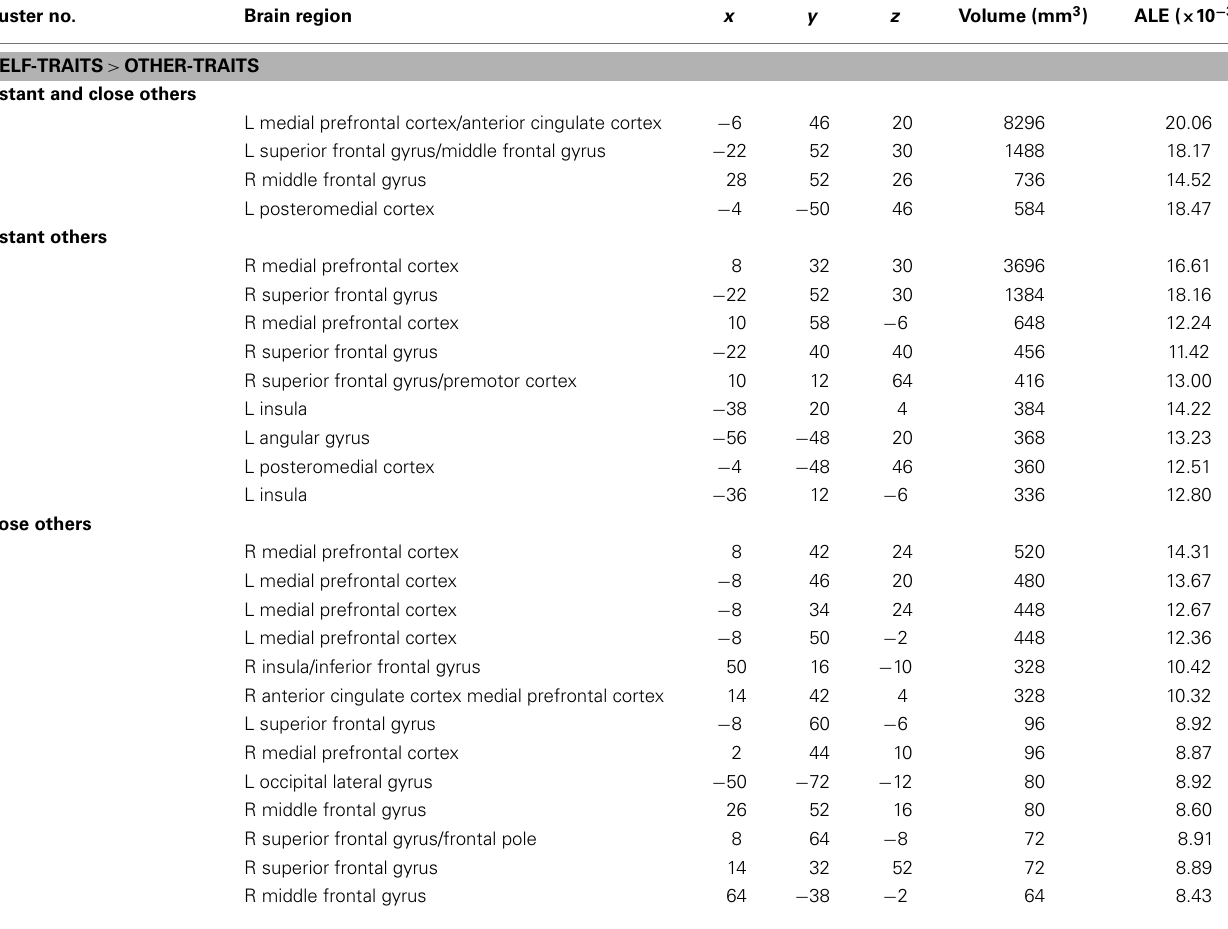
Table 4 | Meta-analysis of activation foci for self-traits compared with other-traits in relation to both kinds of other (148 foci; 22 experiments), to distant kinds of other (98 foci; 15 experiments), and to close kinds of other (50 foci; 10 experiments). Cluster